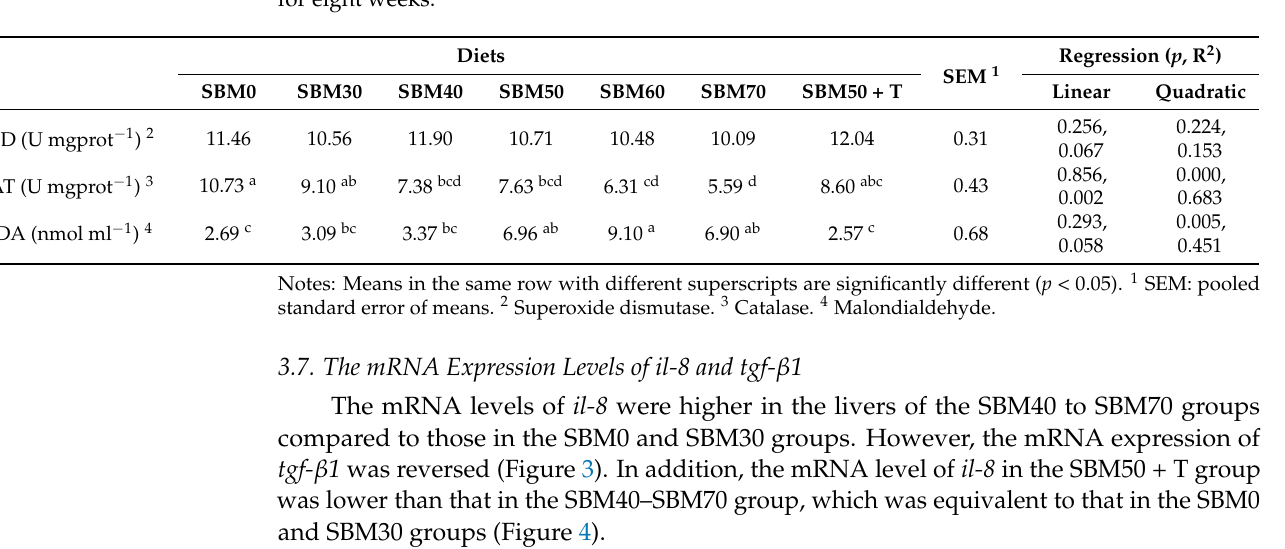
Table 11. Antioxidant parameters in the liver of juvenile Oplegnathus punctatus fed experimental diets for eight weeks.